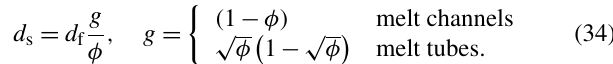
Figure 9. Time- and depth-dependent profiles of the fluid–solid temperature differences as in Fig. 5, but for fluid-to-solid prop- erty ratios typical for water flowing through sedimentary rocks, i.e., = 1. Pe and G have been chosen ρ (cid:48) s c (cid:48) p, s = 0 . 78, κ (cid:48) s = 16, and λ (cid:48) eff as indicated in the panel titles (as in Fig. 5), and φ = 0 . 1 was as- sumed. In each panel the curves show (T f − T s ) profiles for pro- gressive times, and the colors are cyclically varied with time from blue to yellow, starting with blue (bold curve). The first five curves were taken with time increments of 0.4875 and the later curves with 4.875. The total time was 100 in all models with G = 0 . 1 and 200 in the models with G = 0 . 01. Steady state is reached in the models with G = 0 . 1. The model with G = 0 . 01 would need t = 10000 to reach steady